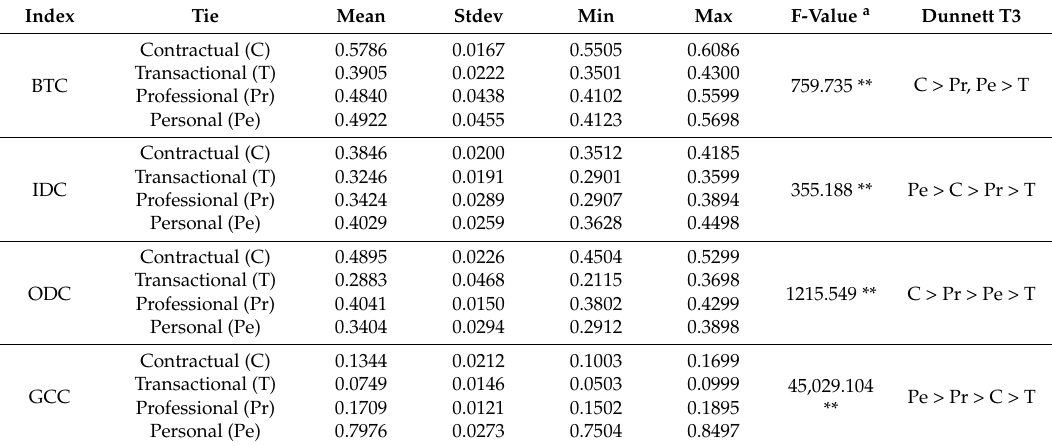
Table 3. Descriptive statistics and ANOVA